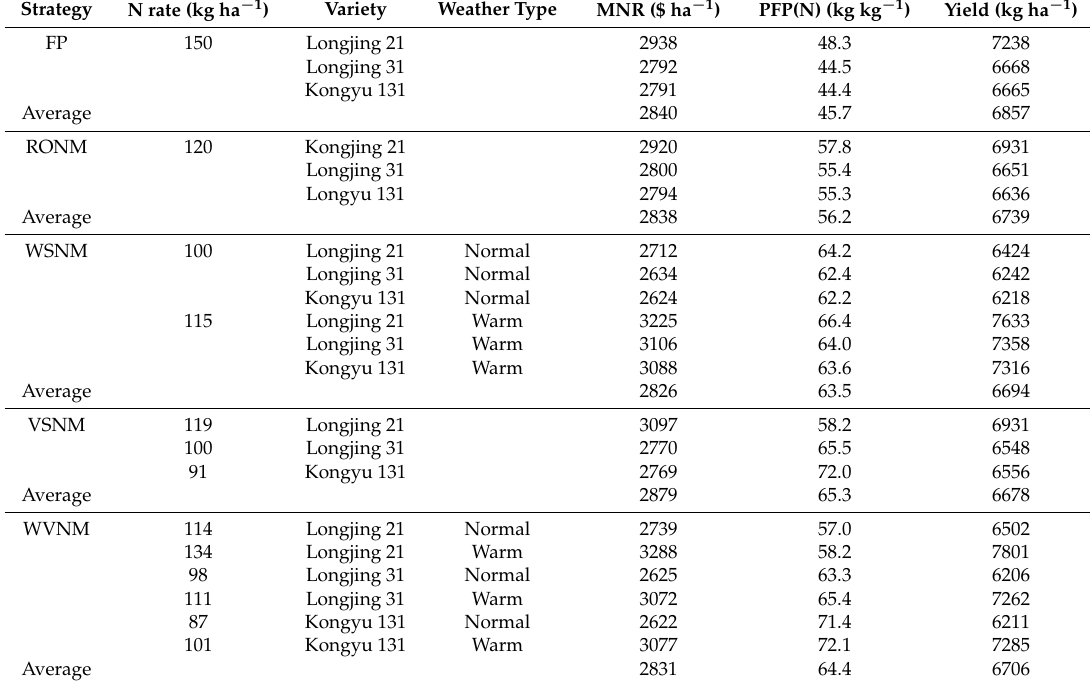
Table 6. Simulated marginal net return (MNR), partial factor productivity (PFP), and yield under five management strategies based on different N rates, rice varieties, and weather